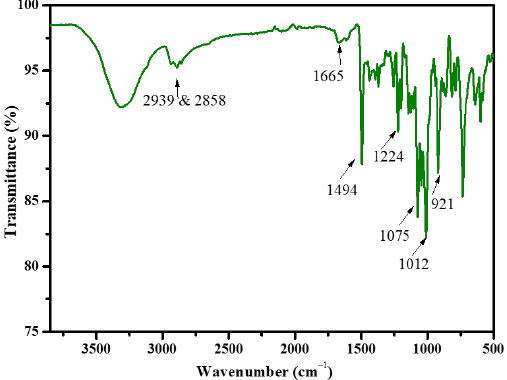
Figure 1. FT-IR spectrum of C-fu benzoxazine.